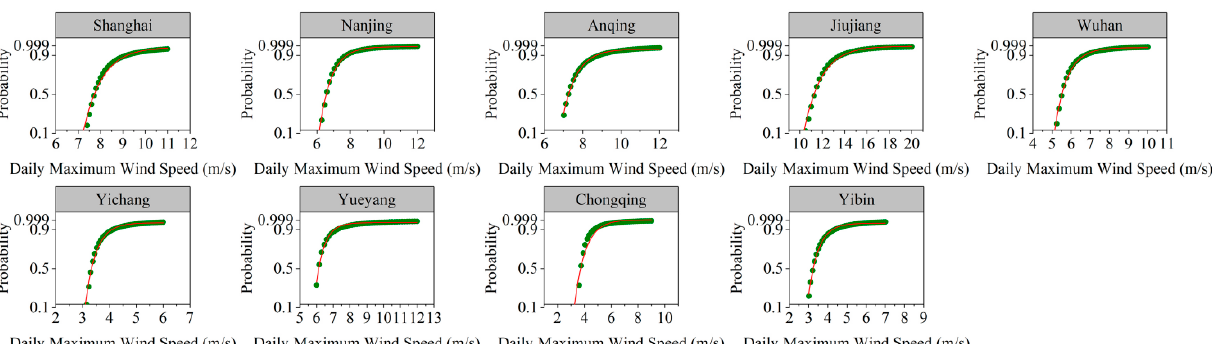
Figure 4. Q ‒ Q plots of the Weibull distribution for nine ports, 1979 ‒ 2020. Figure 4. Q–Q plots of the Weibull distribution for nine ports, 1979–2020.